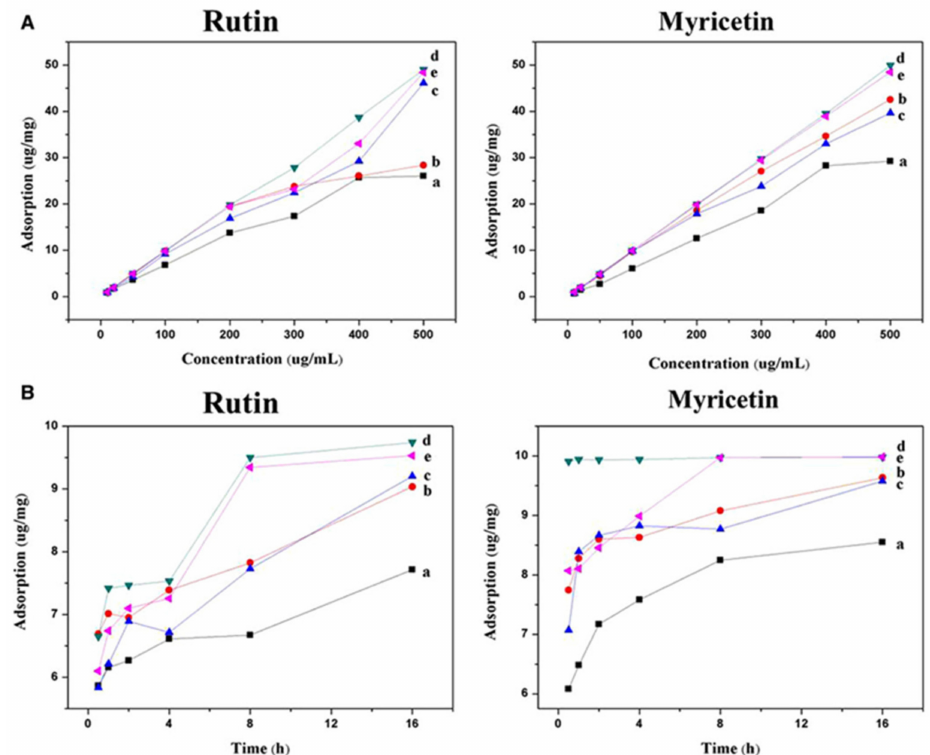
Figure 2. Adsorption equilibrium curves: ( A ) static adsorption capacity of GO (a), N-GO (b), B-GO (c), N-GO-DES (d) and B-GO-DES (e) in myricetin and rutin. ( B ) Dynamic adsorption capacity of GO (a), N-GO (b), B-GO (c), N-GO-DES (d) and B-GO-DES (e) in myricetin and rutin. Reprinted from Sun, L.; Deng, Q.; Zhu, T. Optimization of Heteroatom Doped Graphene Oxide by Deep Eutectic Solvents and the Application for Pipette-Tip Solid-Phase Extraction of Flavonoids. J. Sep. Sci., 2019, 42 (14), 2371–2378 with permission from Wiley